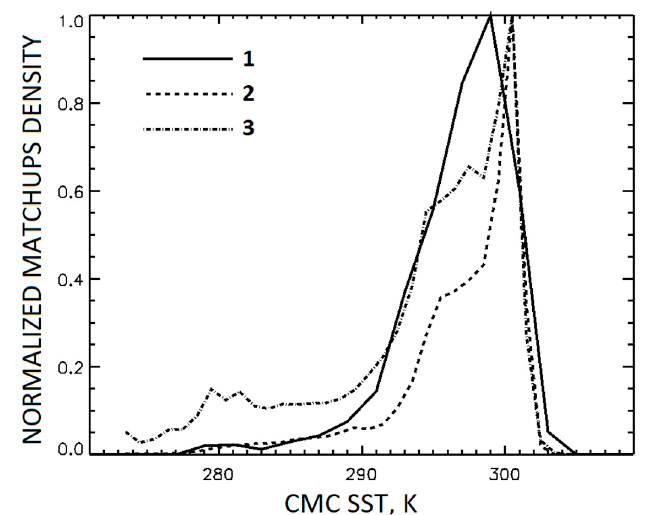
Figure 2. Normalized histograms of matchups within (1) training data set of matchups of satellite observations with in situ SST (TMDS-IS) (N = 795,877) (2) TMDS-L4 (N = 1.19 × 10 9 ), (3) same as (2) but taking into account weights of the pixels within the MDS-L4 (as explained in section 3). All histograms are shown as functions of Canadian Meteorological Center (CMC) SST.